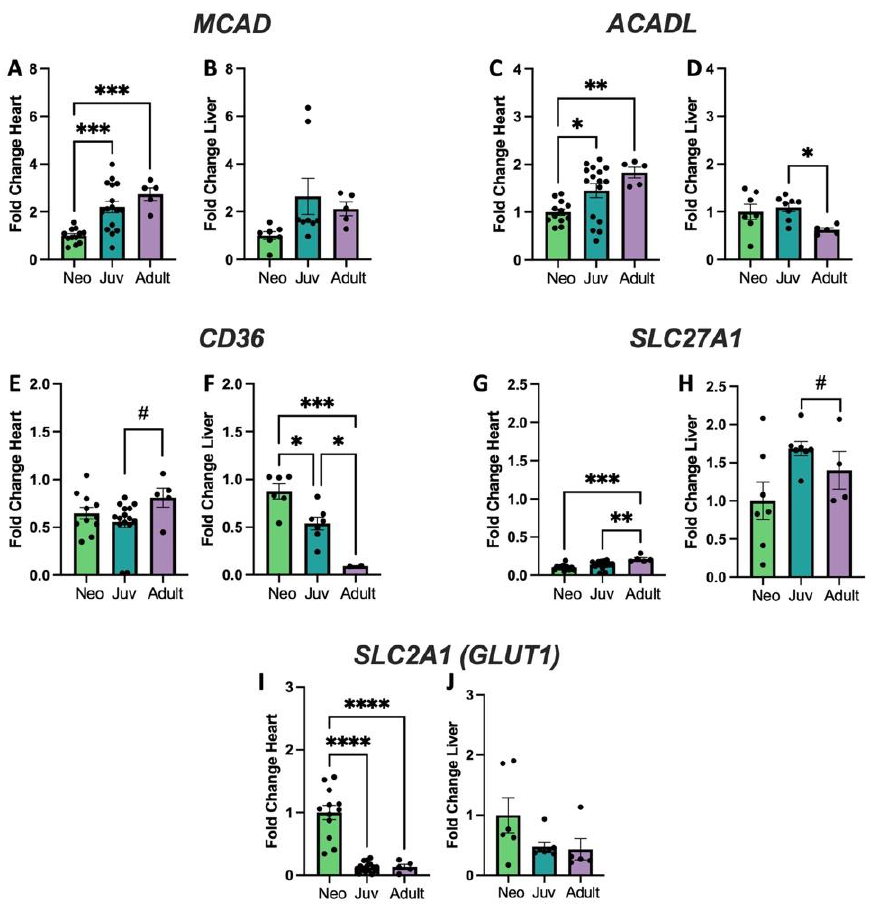
Figure 2. Genes with differential expression in heart and liver. Quantitative rt-qPCR for the genes MCAD , coding for Medium Chain Acyl CoA Dehydrogenase ( A , B ); ACADL , coding for Long Chain Acyl CoA Dehydrogenase ( C , D ); CD36 coding for Fatty Acid Translocase ( E , F ); SLC27A1 , coding for Fatty Acid Transport Protein 1 ( G , H ), and SLC2A1 coding for the Glucose Transporter Type 1( GLUT1 ) ( I , J ). # p < 0.01, * p < 0.05, ** p < 0.01, *** p < 0.001, **** p < 0.0001; N = 5–16 separate animals. Error bars represent standard error of the mean.